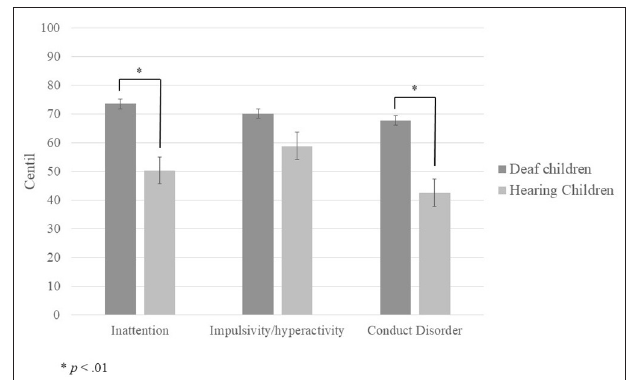
FIGURE 1 | Mean centile scores obtained by deaf and hearing children in each of the EDAH sub-scales.